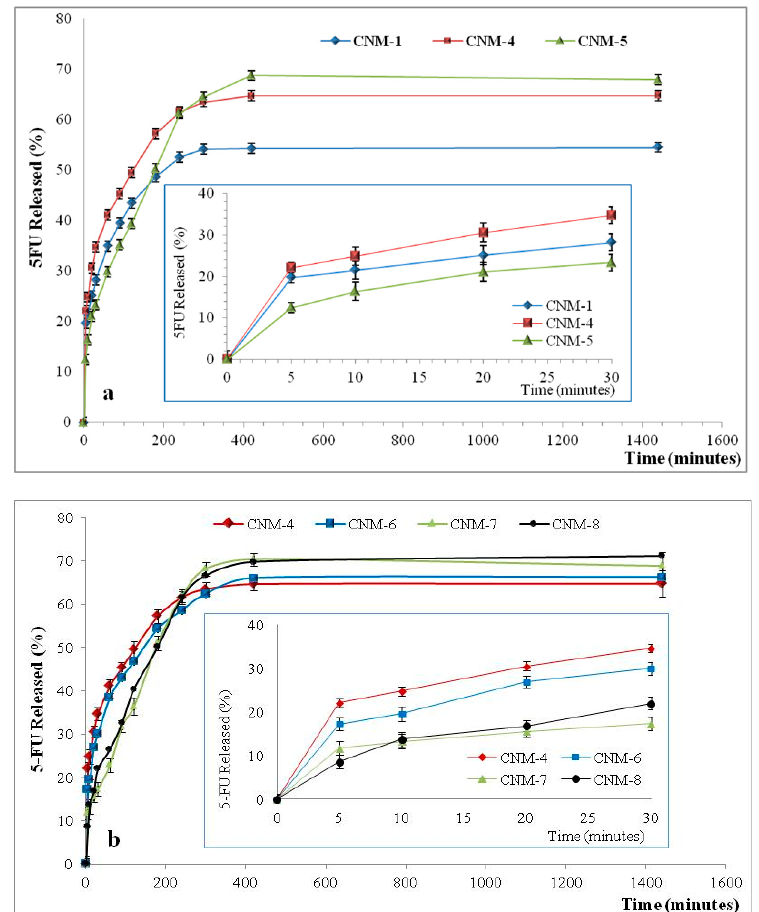
Figure 9. In vitro release kinetics of 5-FU from magnetic NCs in phosphate buffer solution (pH 7.4), with a zoom insert of release kinetics between 0 and 30 min for samples: ( a ) CNM-1, CNM-4 and CNM-5; ( b ) CNM-4, CNM-6, CNM-7 and CNM-8.